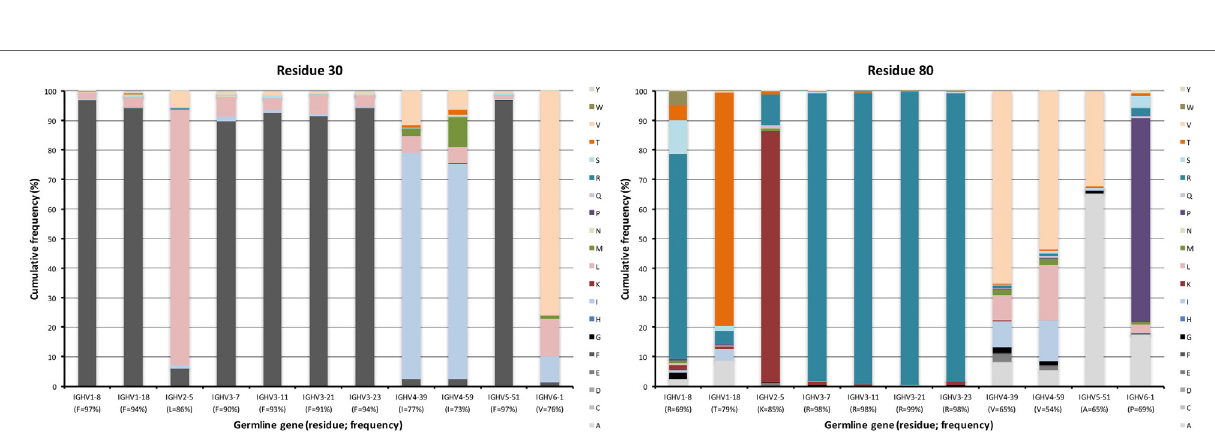
FigUre 8 | Substitutions of charge cluster residues 95 and 97 as introduced during somatic hypermutation processes of IgG-encoding genes derived from different germline